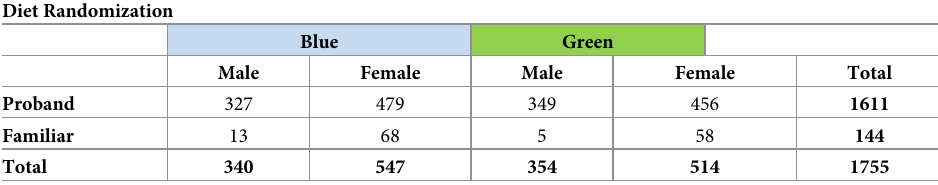
Table 1. Correct balancing of the groups. The term “Proband” refers to the first family member enrolled in the trial and “Familiar” refers to subsequent family members enrolled. Diet